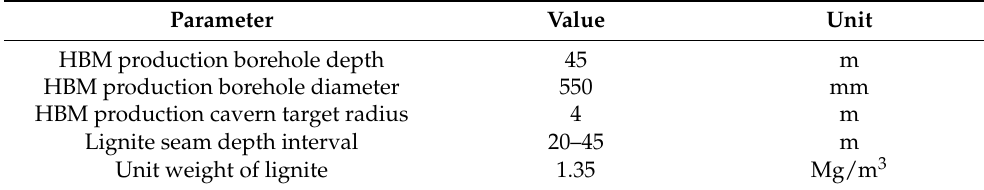
Table 2. Assumptions made in order to describe the defined system sufficiently.